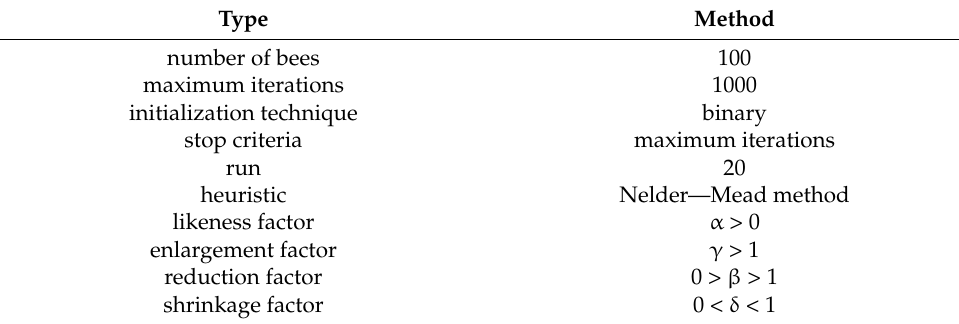
Table 2. Configuration parameters of MBABC-NM for experimental